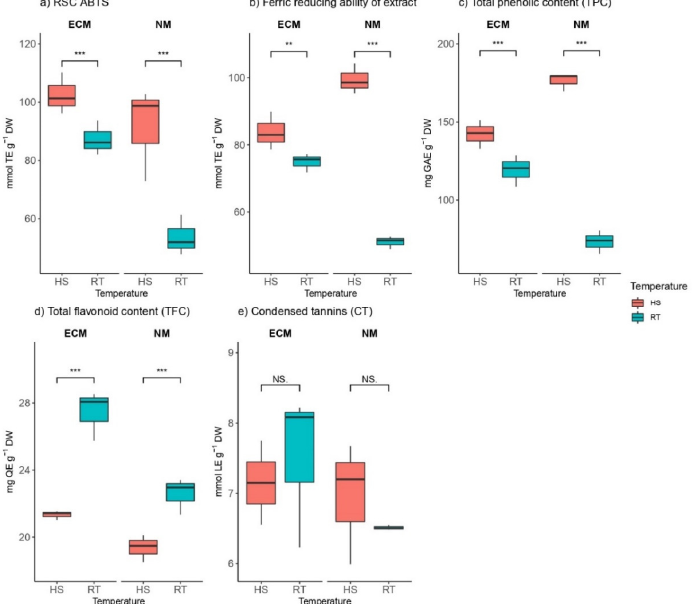
Figure 5. Changes in ( a ) radical scavenger capacity against ABTS (ABTS, mmol TE g − 1 DW), ( b ) ferric reducing ability of extract (FRAP, mmol TE g − 1 DW), ( c ) total phenolic content (TPC, mg